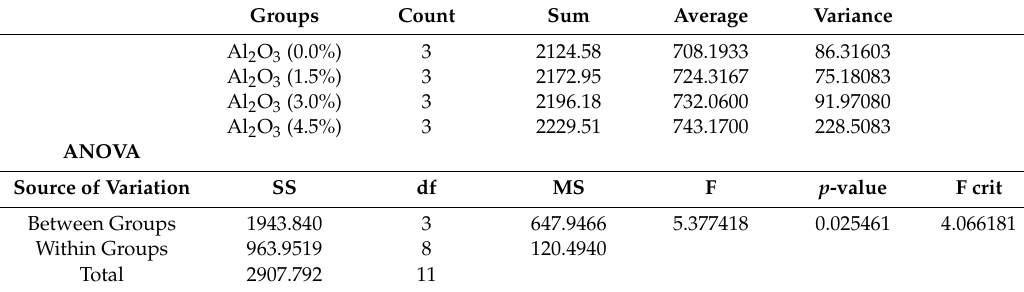
Table 6. Density values of Al 2 O 3 -UF MDF for various treatments.